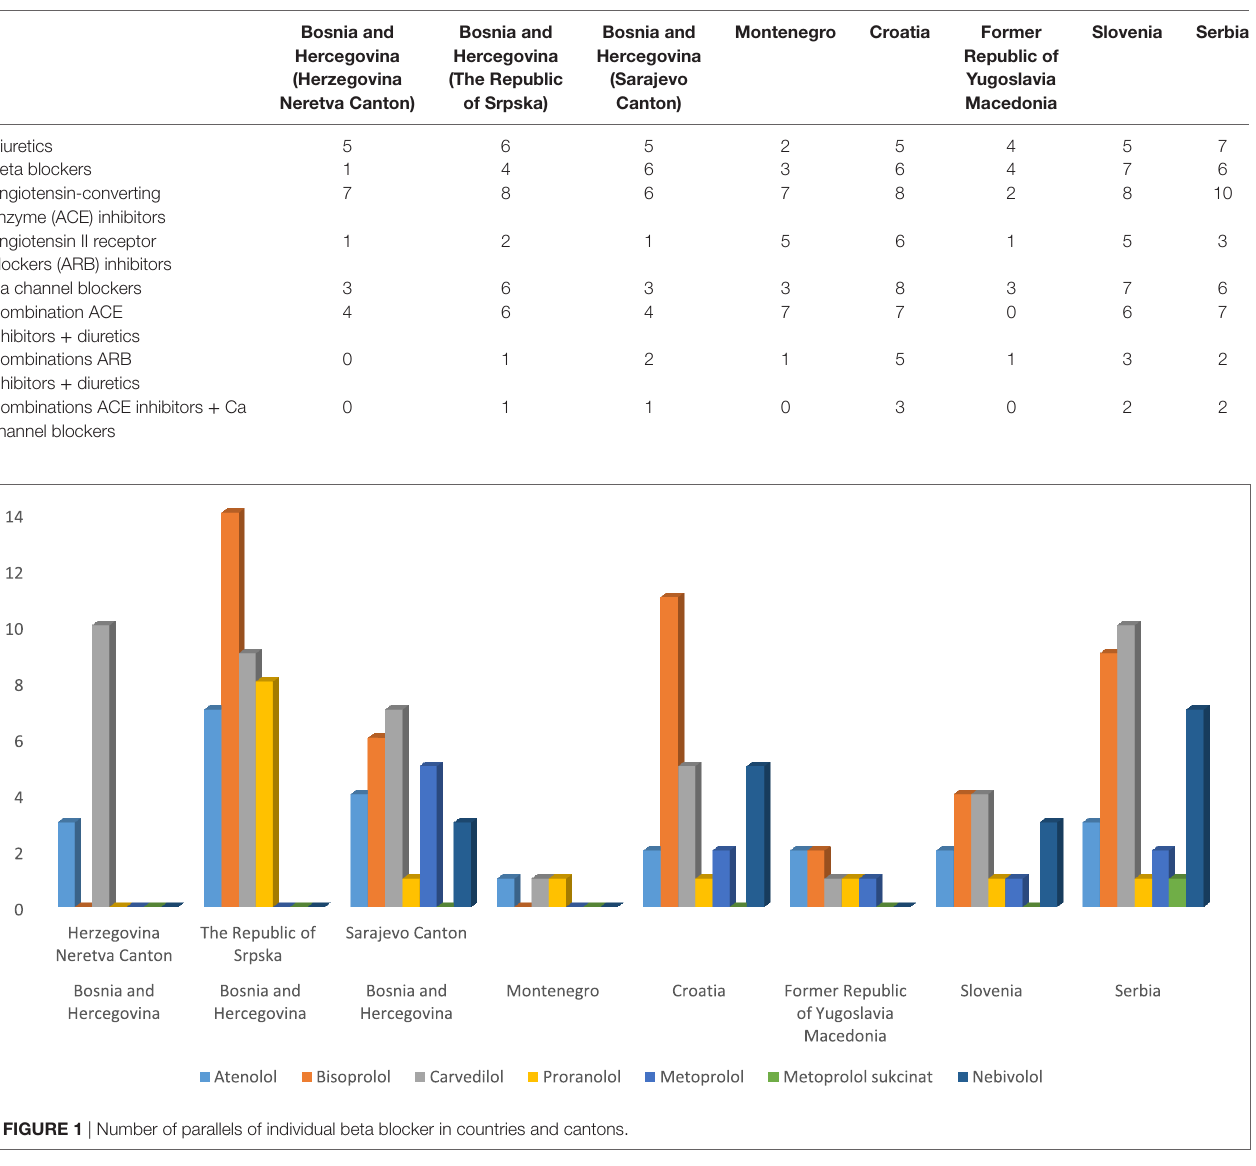
TaBle 1 | Number of medicines for treatment of hypertension according to groups, countries, and cantons.